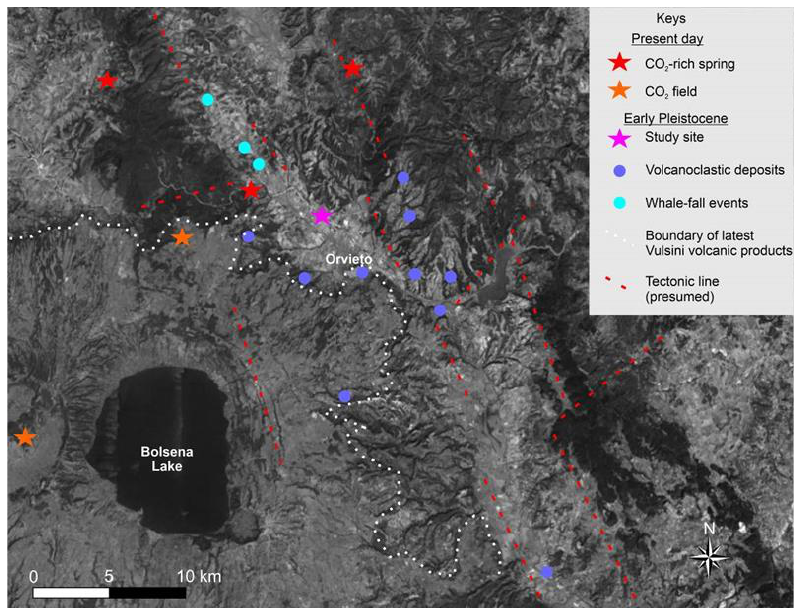
Figure 9. Aerial distribution of Early Pleistocene volcanoclastic deposits, whale-fall events (WFE), and present-day emergences of CO 2 ; the boundary of the latest (Late Pleistocene) Vulsini volcanic products and the main tectonic lines are also shown. Data are from [28,34,59,65]. If the degassing process occurred in a relatively shallow marine environment, the volcanic CO 2 seepage could have produced high values of CO 2 partial pressure (pCO 2 ) and the acidification of seawater, with the consequent undersaturation in calcite and arag- onite, similar to that which is currently observed in present-day submarine volcanic hy- drothermal fields [69].